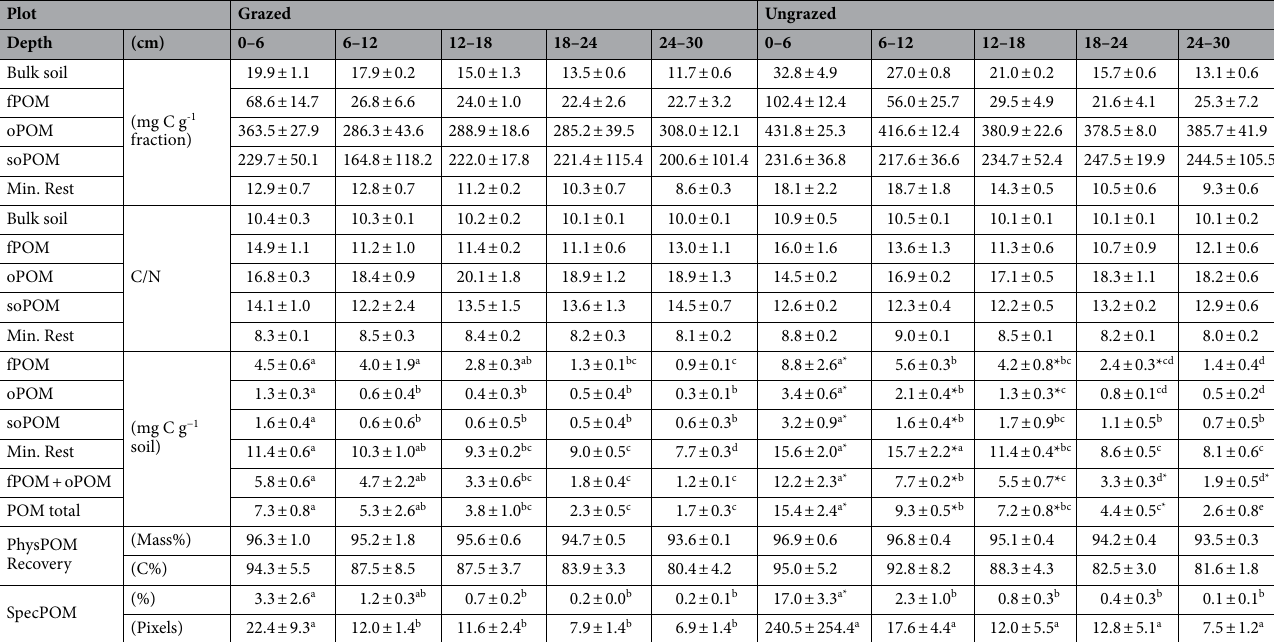
Table 1. Characteristics of physical soil organic matter fractions (PhysPOM) and spectroscopically identified organic matter (SpecPOM) fractions. Characteristics are given as mean values and standard deviations and were calculated from four data points (two profiles per plot × two blocks per sampling depth in each profile). The first section shows the carbon concentrations, the second section the C/N ratio, and the third section the carbon stocks as calculated from carbon concentrations and masses. Different letters in the third and fifth section show significant differences between the five sampled depths for the respective plot (ANOVA with the least significant difference test as post hoc test). Asterisks in the third and fifth sections show significantly different numbers between the two plots in the respective fraction and sampling